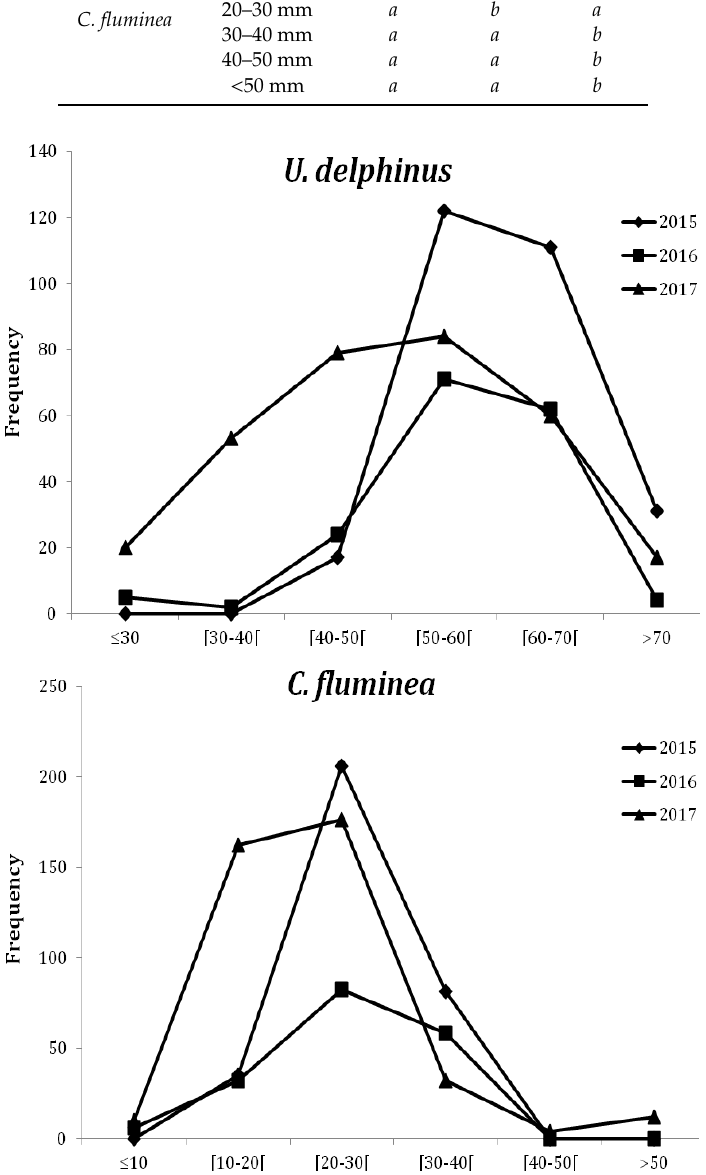
Figure 5. Size frequency distributions (according to the different size classes) of U. delphinus and C. fluminea from 2015 to 2017 (pooled data from six pools).